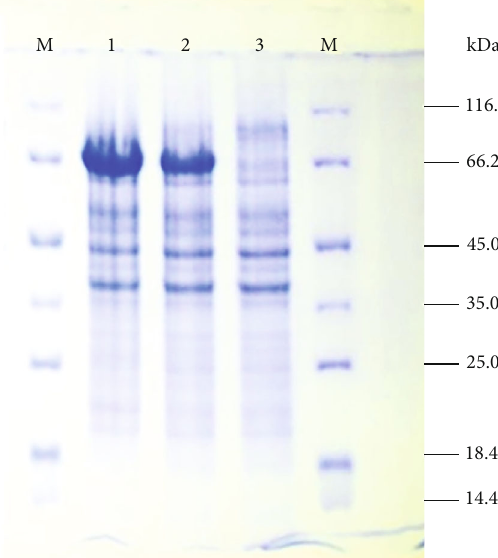
Figure 5: SDS-PAGE analysis for partial puri fi cation of chitinase from Bacillus licheniformis (SSCL-10). M: Marker, 1: cell extract fraction of wild-type strain, 2: cell extract fraction of UV mutant 11, 3: cell extract fraction of